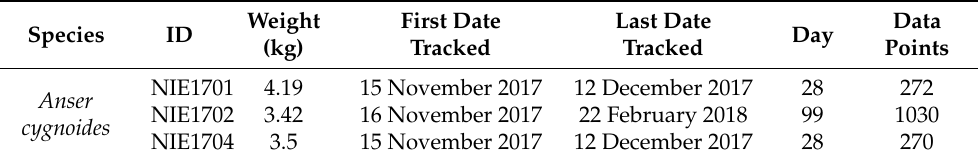
Table 1. Description of GPS tracking for three Swan Geese. The GPS tracking dataset was limited to the period of stay around the Seocheon Tidal Flat, and the individual (NIE1703) that left after attaching the tracker was excluded from this